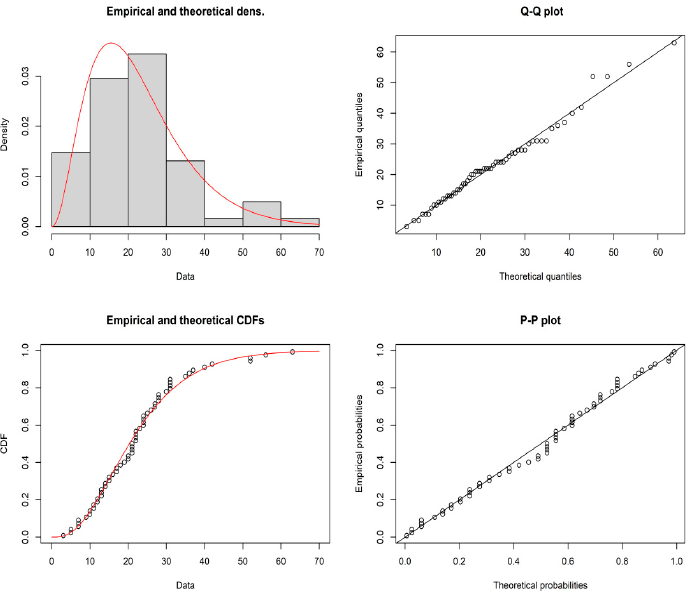
Figure 3. Pictorial presentation of various plots for the GD for daily number of cases data. Table 9. The MDS design values for 𝛼 = 0.10,𝜈 = 3.1946, and 𝑎 = 0.50 .